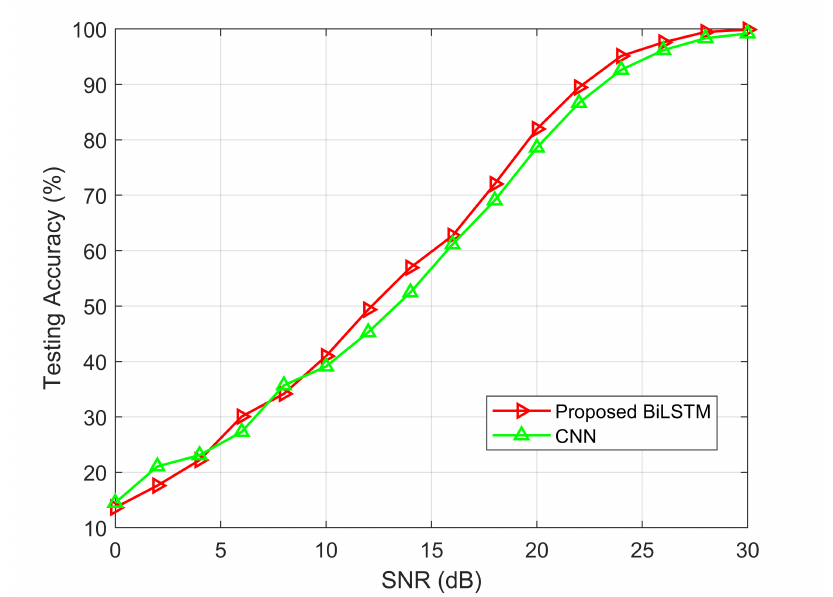
Figure 13. Testing accuracy performance of Bi-LSTM and CNN